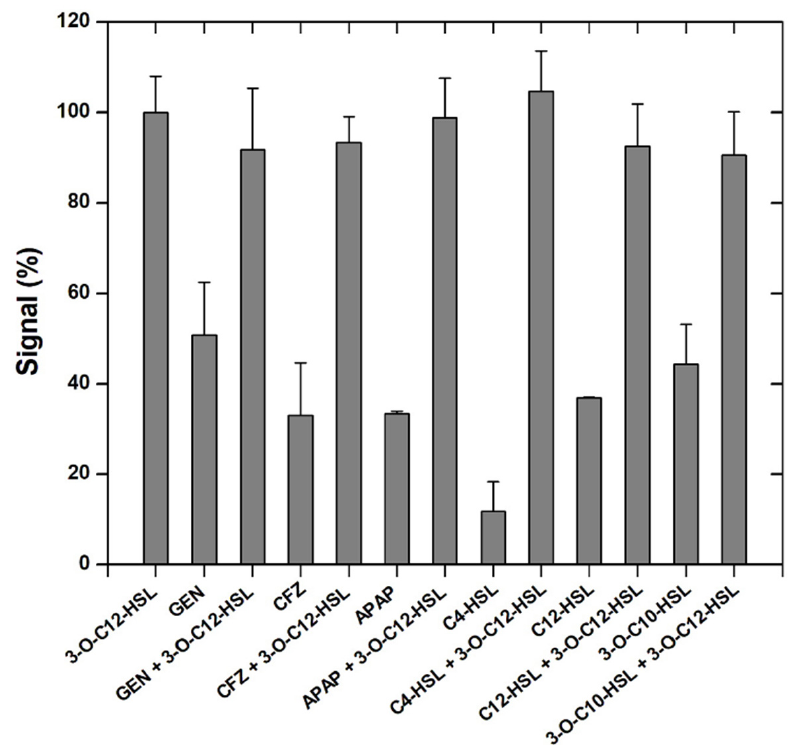
Figure 11. Aptasensor selectivity studies.